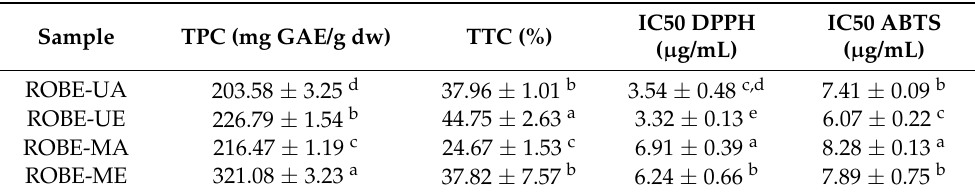
Table 1. Total polyphenolic content (TPC), total tannin content (TTC), and antioxidant activity of